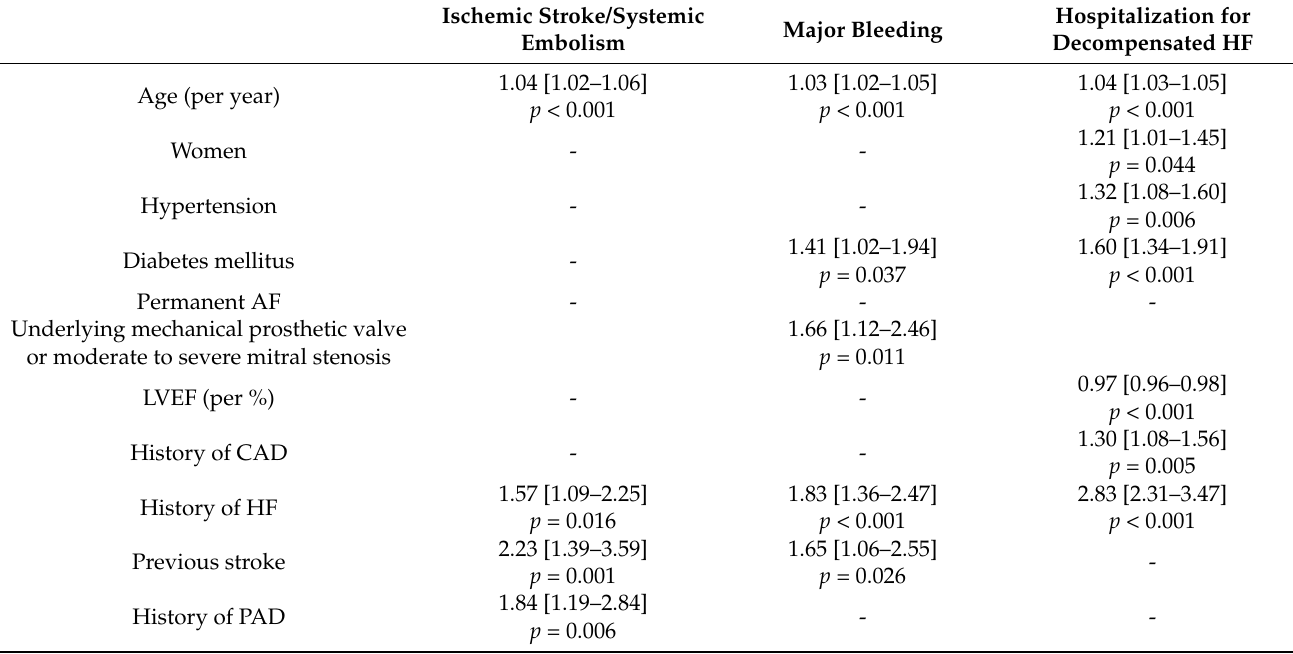
Table 2. Multivariable analysis for correlates of incident events in outpatients with atrial